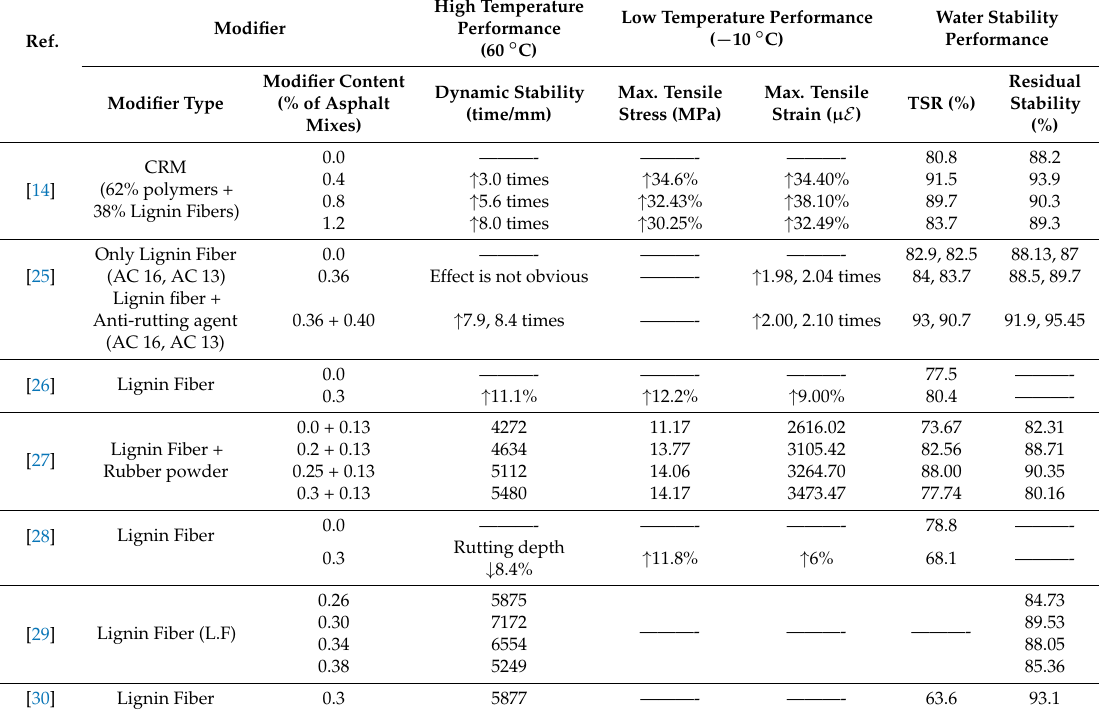
Table 4. Part of summary of lignin fiber modified asphalt mix for improving pavement performance